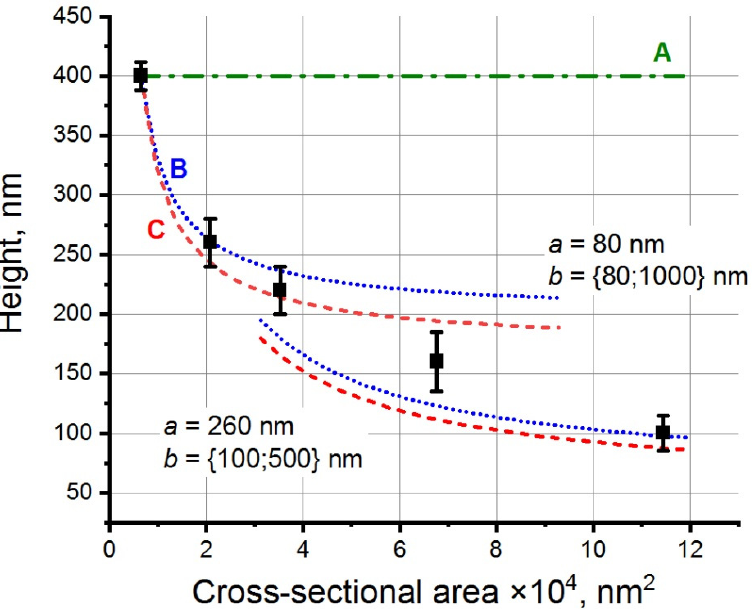
Figure 5. The height of vertical VO 2 NWs as a function of their cross-sectional area. Black squares are the experimental points, straight line A (green dash dot) is the NW height dependence on the NW base area calculated on the assumption of the direct deposition of VO 2 species from the gas phase, and curves B (blue short dot) and C (red short dash) are the dependences calculated by taking into account the diffusion of VO 2 particles to the NW apices from the lateral surface of NWs and from the region of the substrate around the NWs, where there is no VO 2 crystal growth.